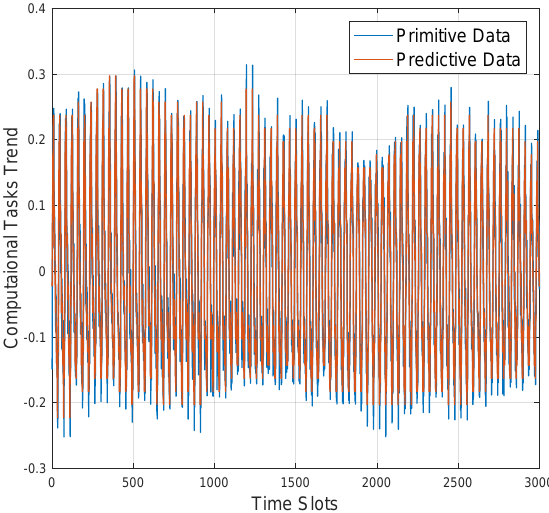
Figure 5. The training stage for LSTM-based resource availability